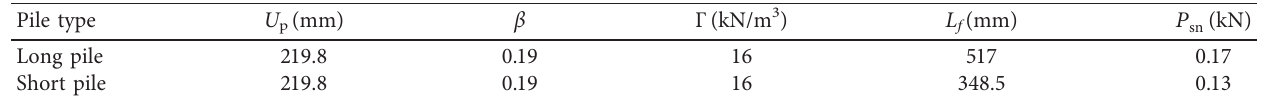
of long and short piles. sn